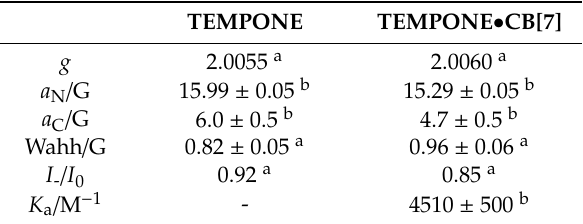
Table 1. EPR parameters for TEMPONE and the host:guest 1:1 complex. Wahh, width at half-height. TEMPONE